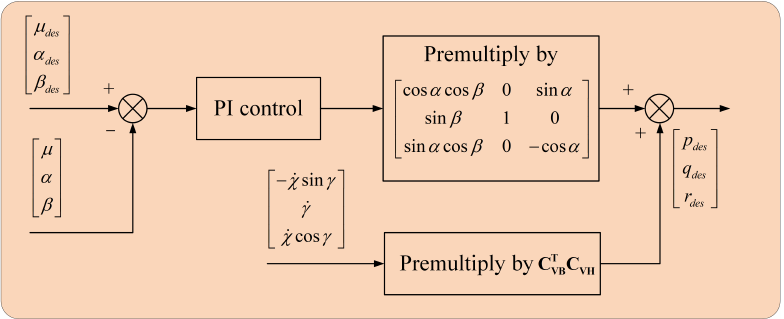
Figure 9. The control block diagram of the attitude